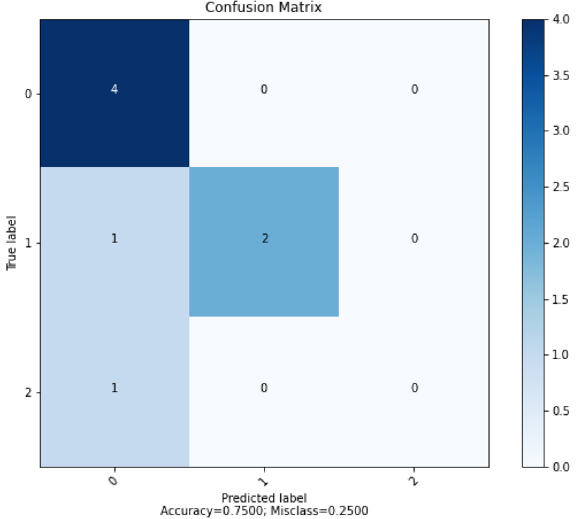
Figure 15. Confusion matrix for